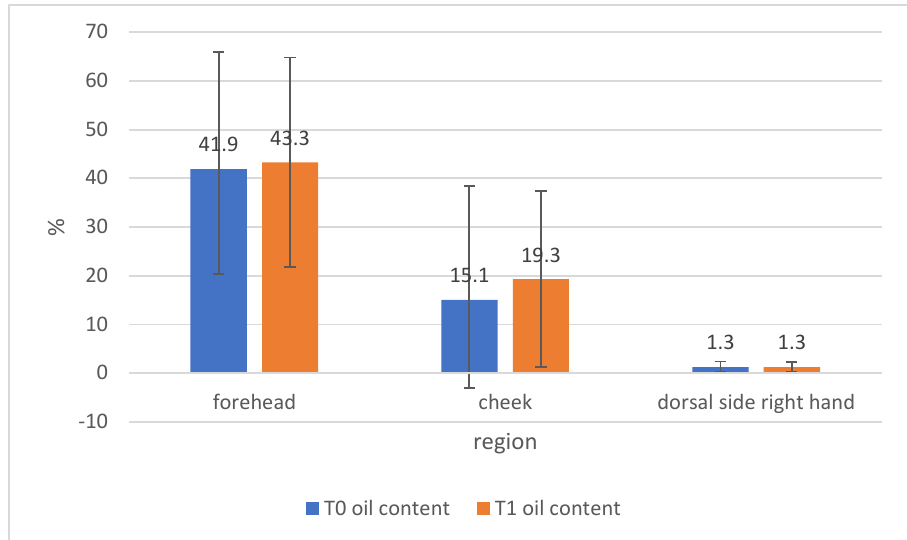
Figure 5. Oil content of the skin in professional dancers at T0 and T1; n = 35.